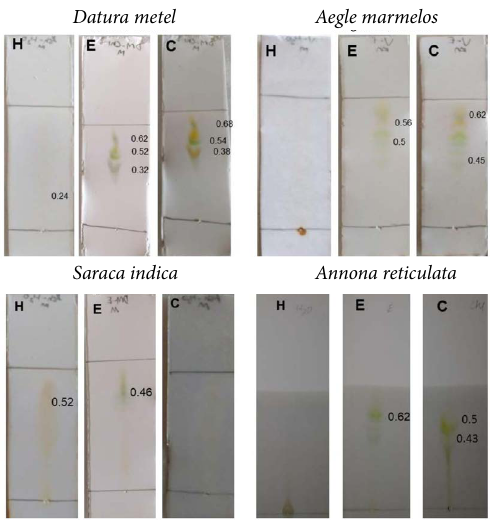
Fig. 2. UV light exposed Thin layer chromatography of medicinal plants chosen for this study. H – aqueous extract, E – ethanol extract, C- Chloroform extract